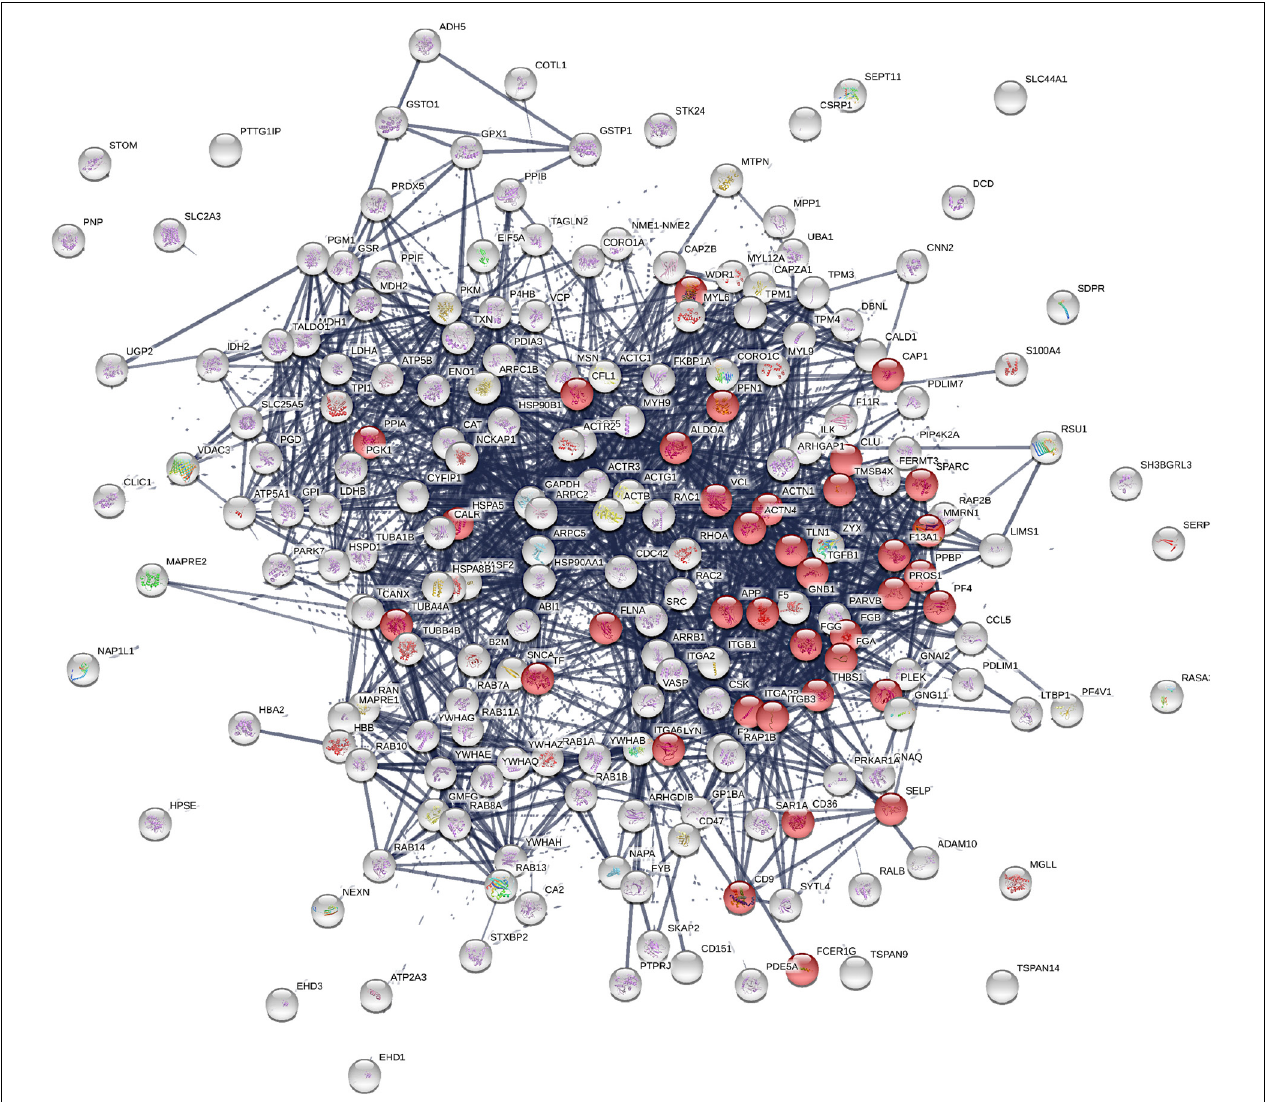
FIGURE 2 | Protein-Protein interaction network of the 214 identified proteins: network nodes represent proteins, network edges indicate the strength of data support (STRING v10.5). Proteins associated with “Platelet activation” pathway are highlighted in red.